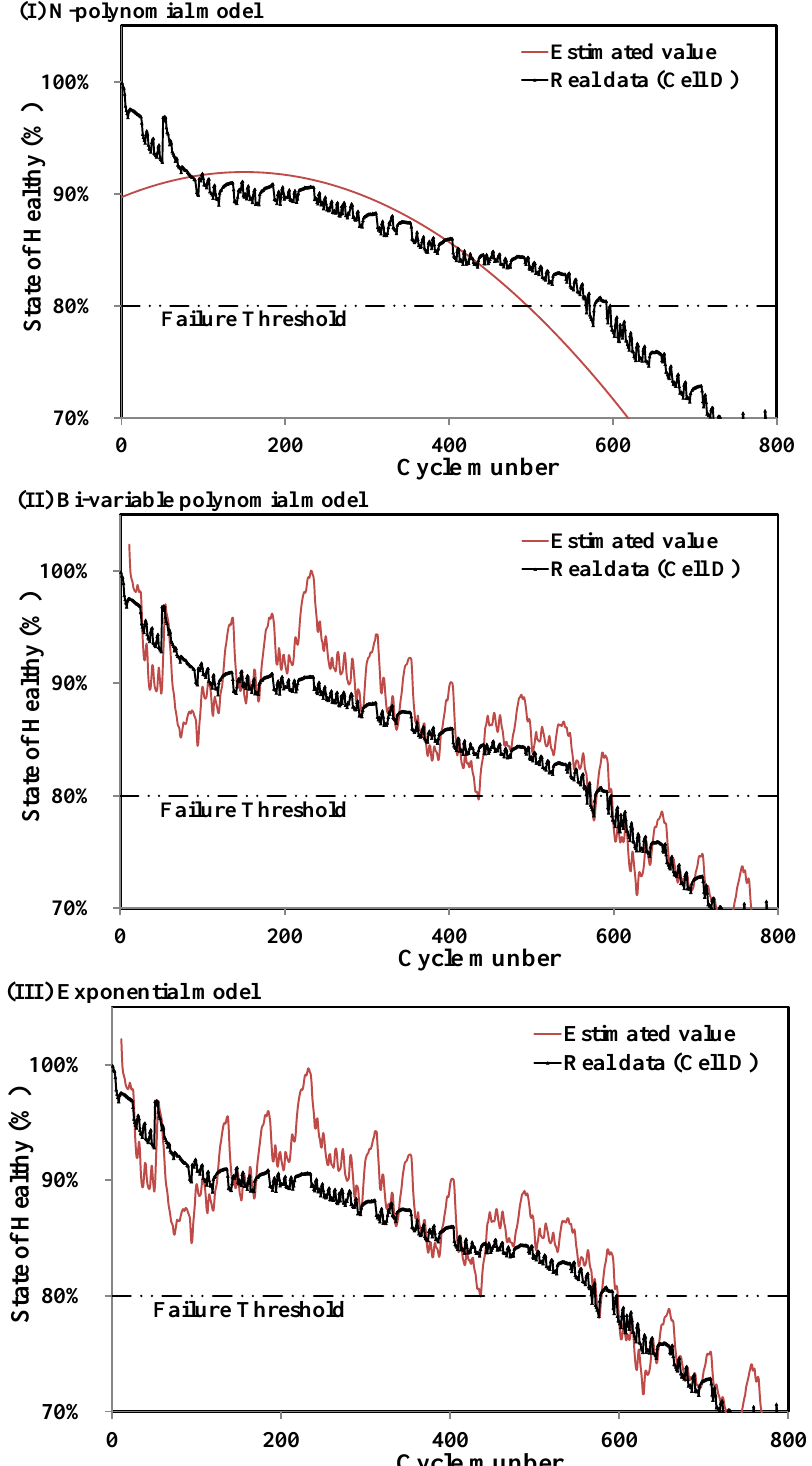
Figure 8. SOH calculations compared with D’s test